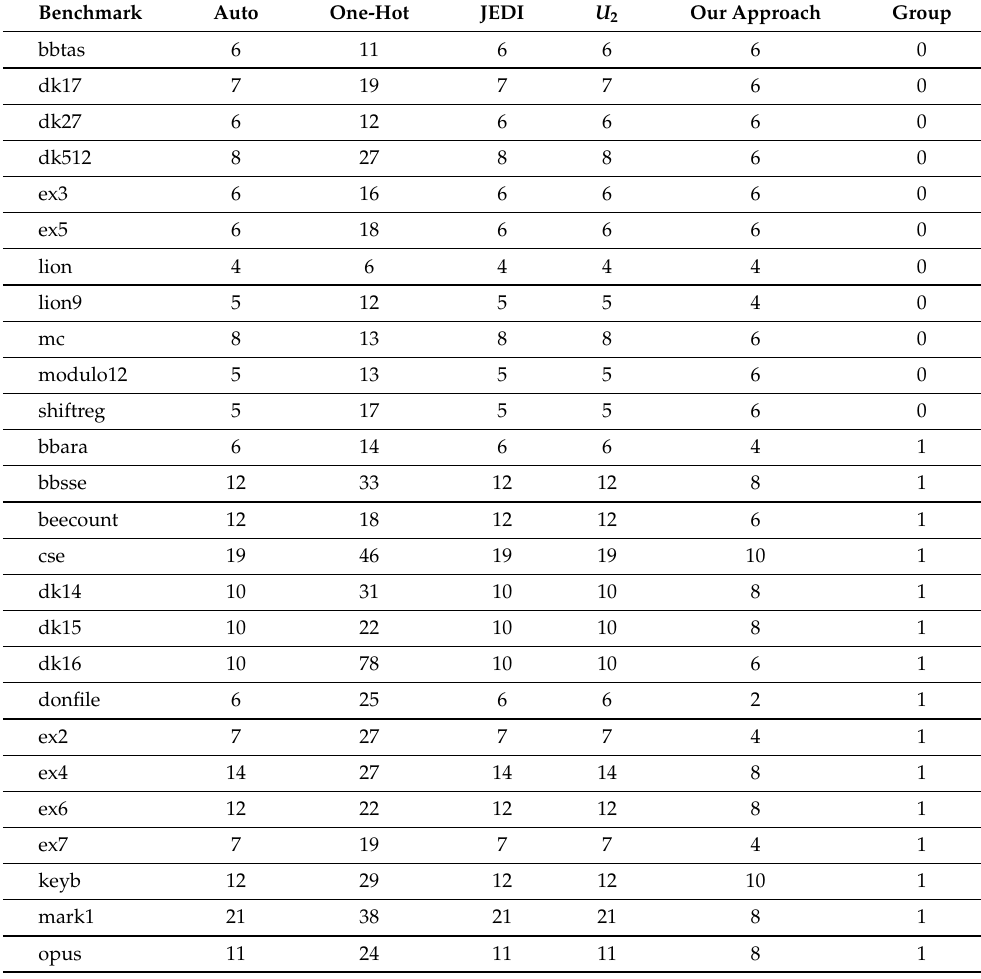
Table 17. Experimental results (number of flip flops with regard to the register of